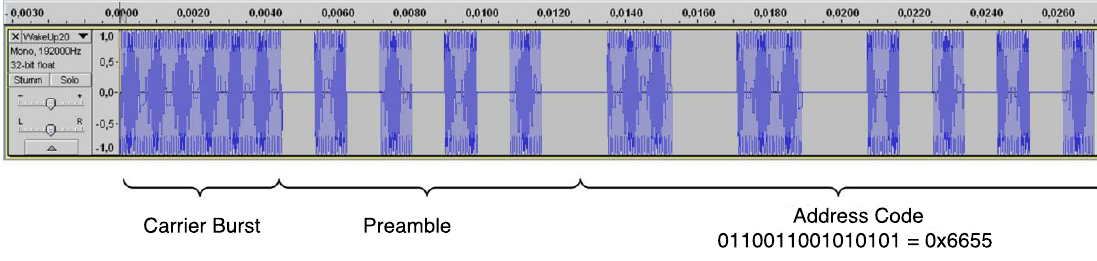
Figure 5. Acoustic wake-up